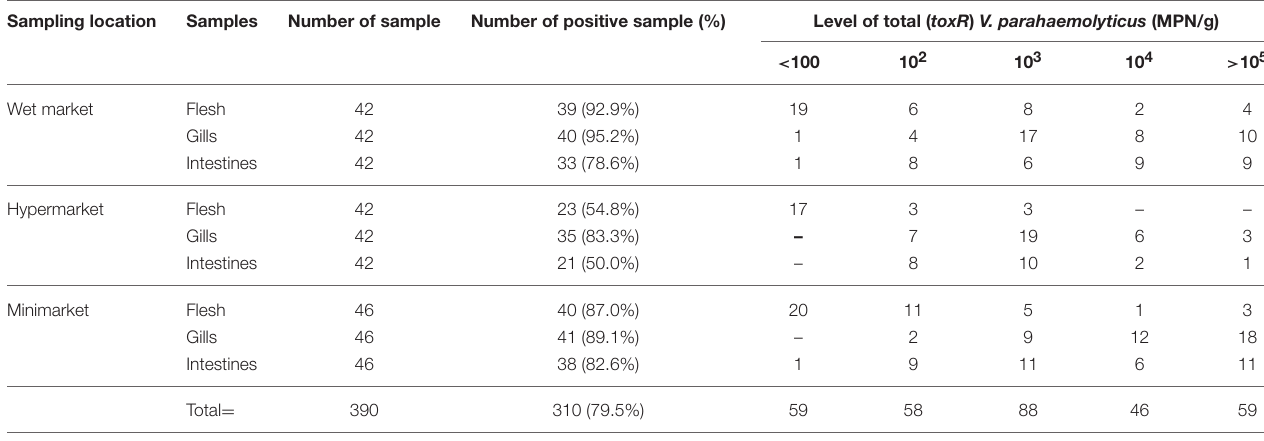
TABLE 1 | Prevalence and microbial loads of total V. parahaemolyticus in short mackerels.